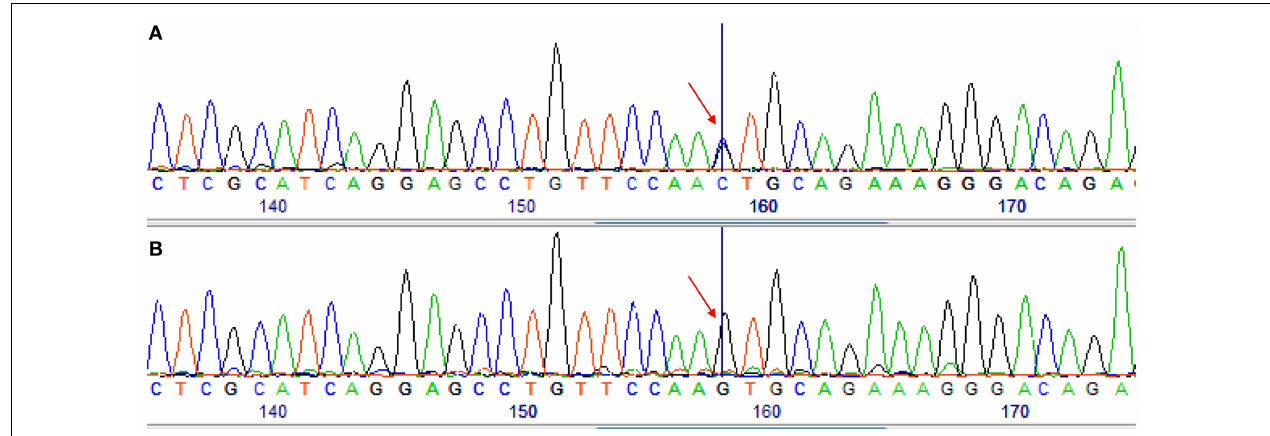
FIGURE 2 | Sequencing chromatograms obtained by sequencing of the PNOC -PCR products for two different samples . (A) A sample identified as Equus asinus by Cytb sequencing. (B) A sample identified as Equus caballus by PNOC and Cytb sequencing. Arrow shows the difference between the two samples.